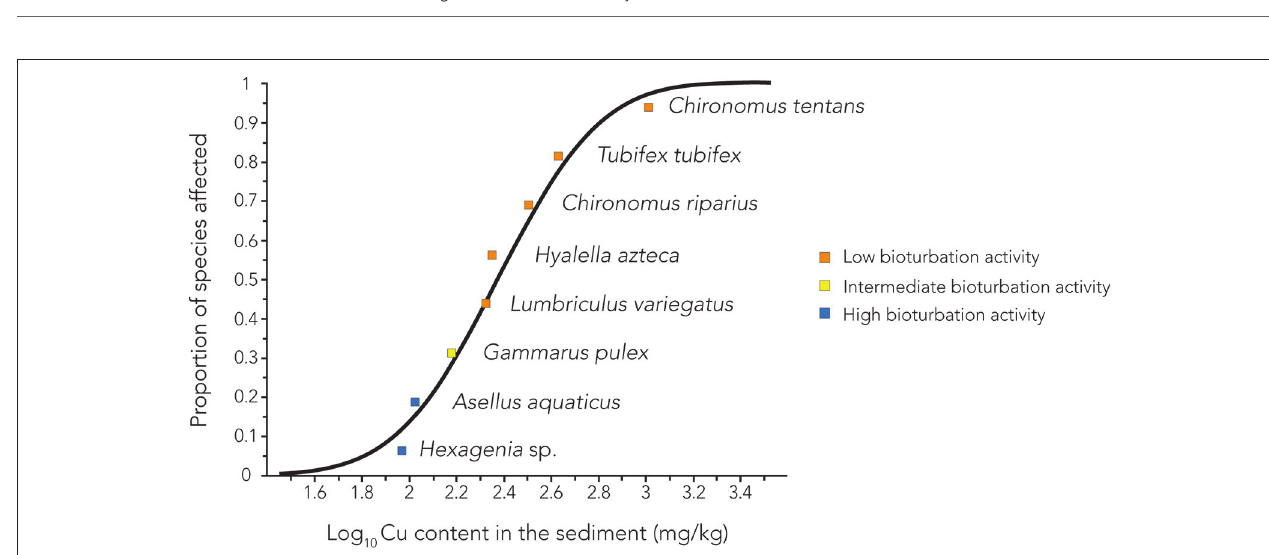
FIGURE 1 | Species sensitivity distribution for sediment associated copper: Benthic invertebrates are categorized according to their bioturbation activity.